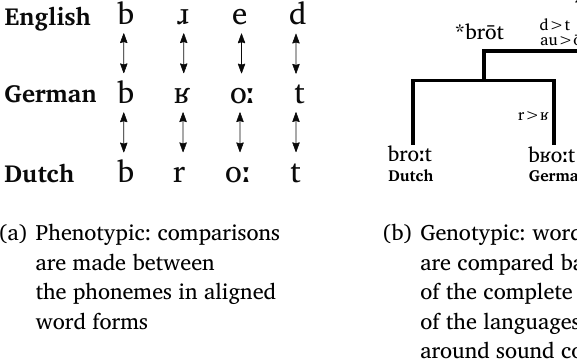
Schematic visualization of the difference between